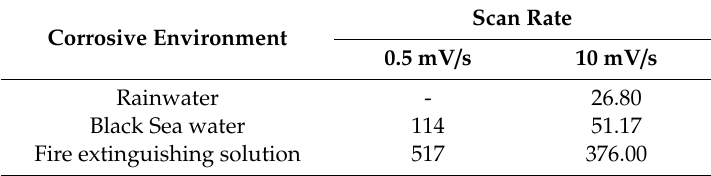
Table 14. Comparison between corrosion rates (v cor -in µ m / year) for the OPS